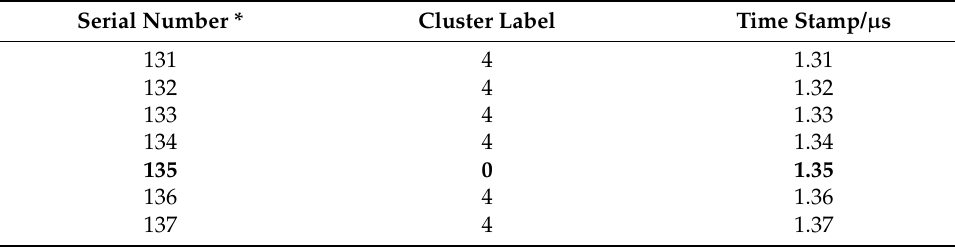
Figure 8. The number of the sheath current samples in each cluster of the HV cable circuit. Table 4. The clustering results of some data